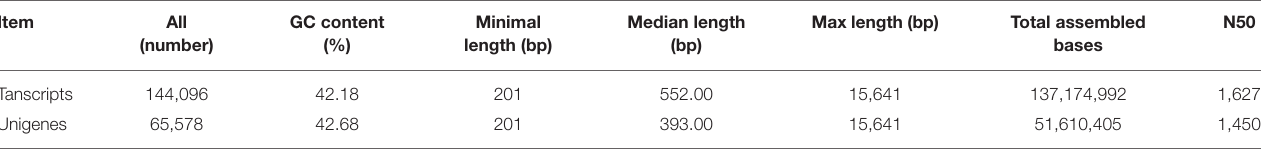
TABLE 1 | Statistics of de novo assembly of Tetrastigma hemsleyanum tuberous-root transcriptome. Item